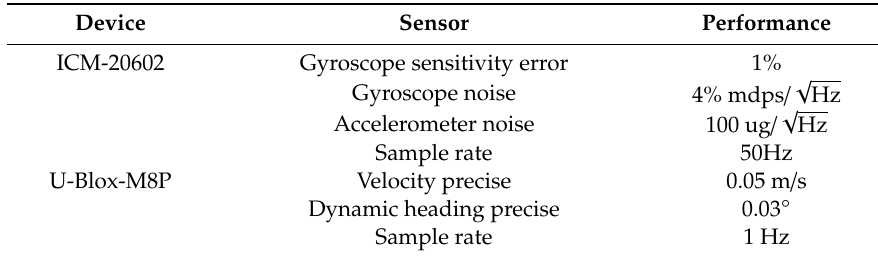
Figure 8. Vehicle with navigation system equipment. Table 1.